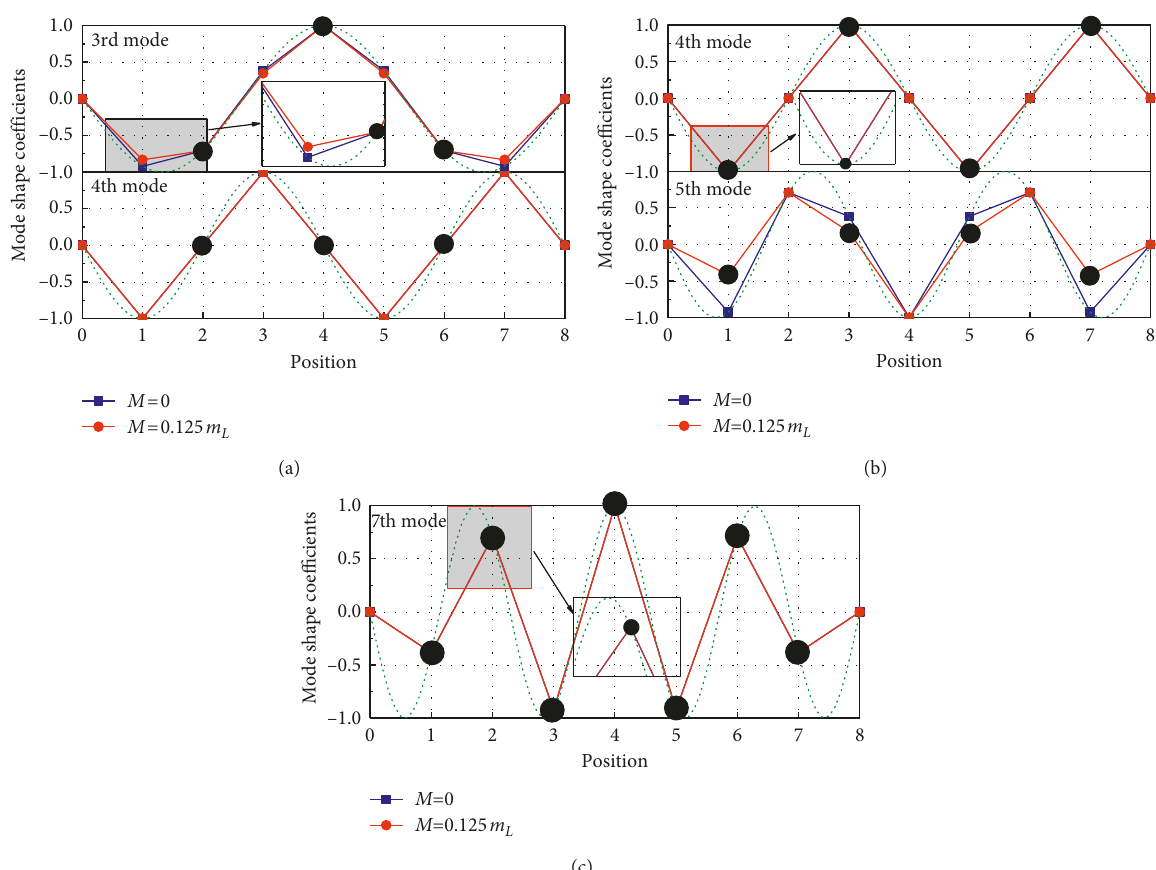
Figure 7: Mode shape variations of the simplified model with several additional concentrated masses: (a) 3 concentrated masses on position 2, 4, and 6; (b) 4 concentrated masses on position 1, 3, 5, and 7; and (c) 7 concentrated masses on every position.